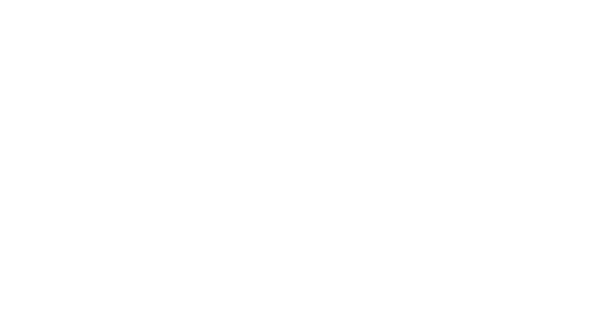
0.5 Table 1. C fx Re x numerical values versus various parameters.